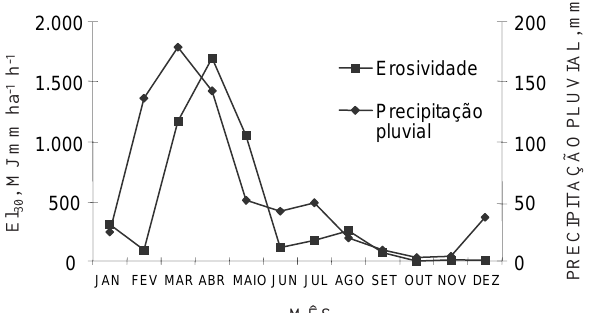
1. Distribuição temporal dos valores médios mensais da erosividade das chuvas e da precipitação pluvial, em Sumé